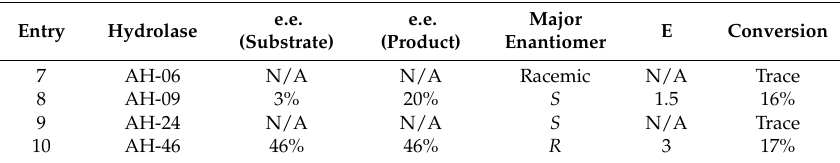
Table 4. Positive hits for hydrolase screen of ( rac )- 4 using DMSO as cosolvent.